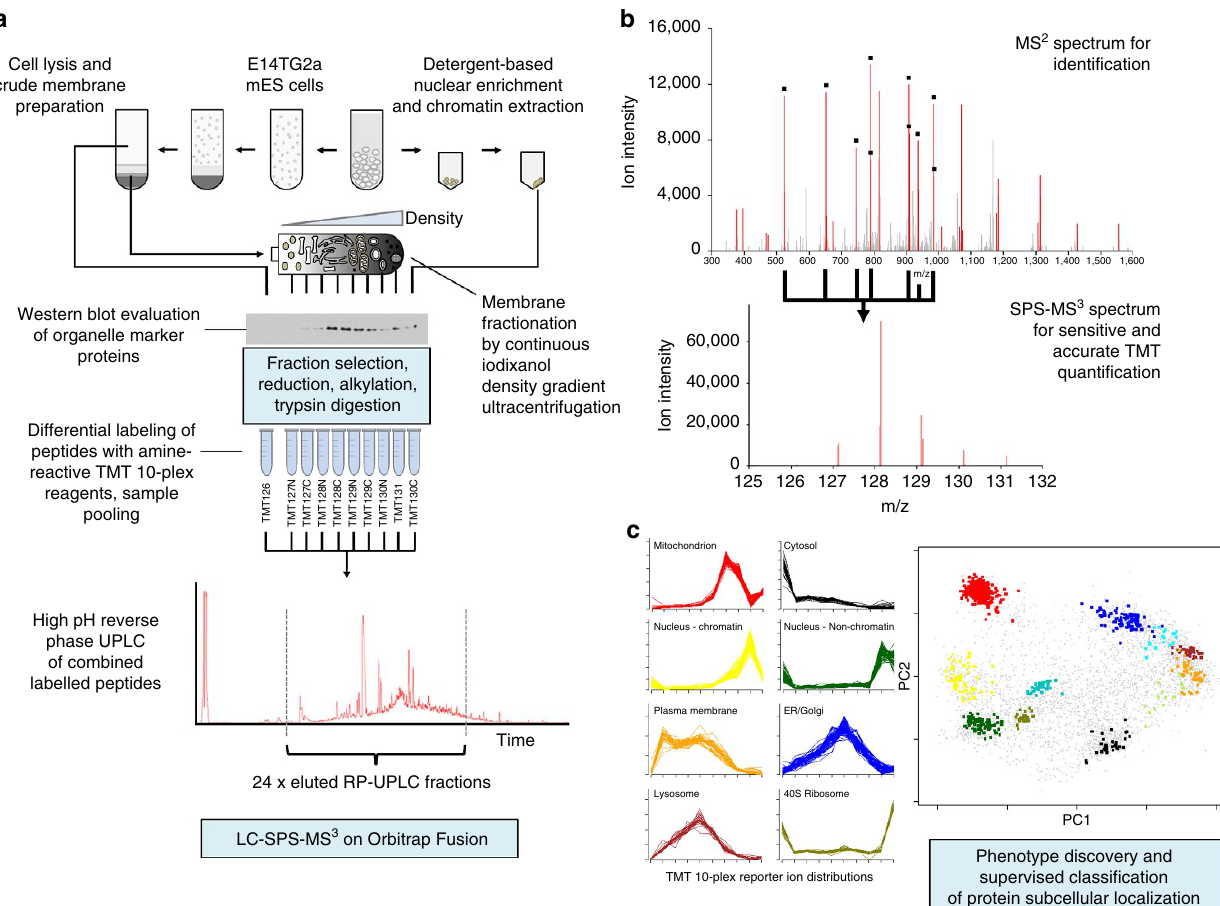
Figure 1 | Schematic of the hyperLOPIT workflow. ( a ) Ten enriched subcellular fractions were generated from E14TG2a murine ES (mES) cells. Peptides derived from each fraction were differentially labelled with TMT 10-plex reagents, and analysed by two-dimensional LC-SPS-MS 3 . ( b ) SPS-MS 3 boosts the sensitivity of MS 3 -based TMT quantification, while preserving the gains in quantitative performance relative to conventional MS 2 , by selecting multiple peptide fragments rather than a single ion for MS 3 analysis. ( c ) TMT reporter ion distributions recapitulate the distribution of proteins across the fractionation scheme. Different organelles display characteristic distributions that may be used to determine their residents. The high dimensional data are presented in two-dimensions by PCA to provide an intuitive visualization of organelle